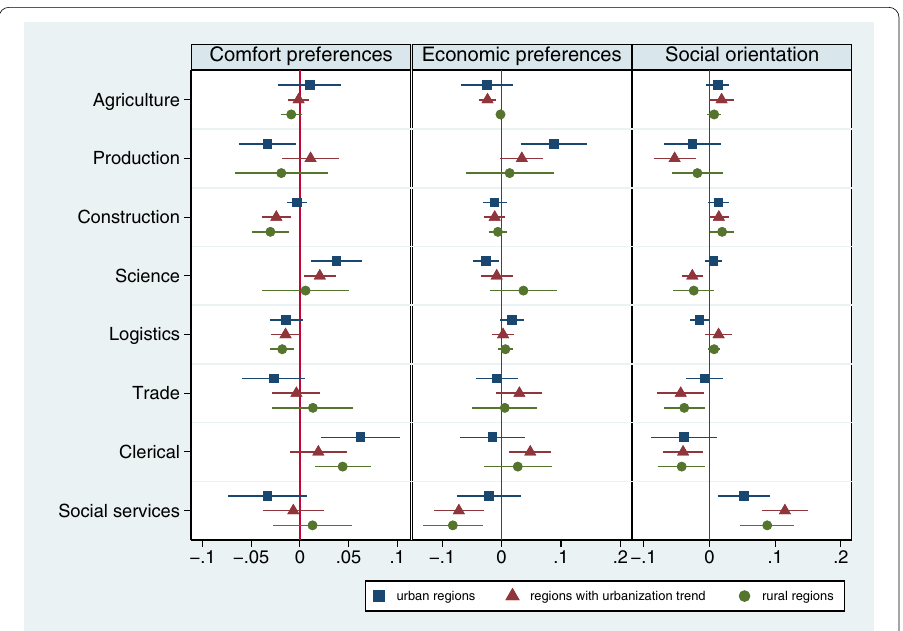
Fig. 5 Effects of economic, comfort and social orientation by the type of region (interaction effects). Data source: NEPS, SC4, estimation see Table